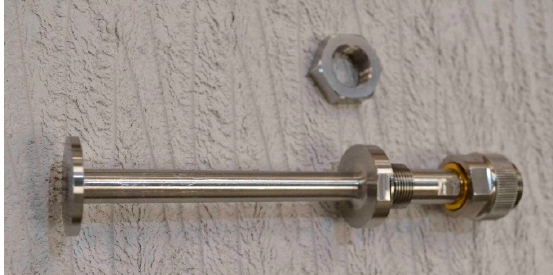
Figure 3. Photograph of one of the 7-mm open-ended coaxial probes. Probe A is shown, but Probe B is of identical design.